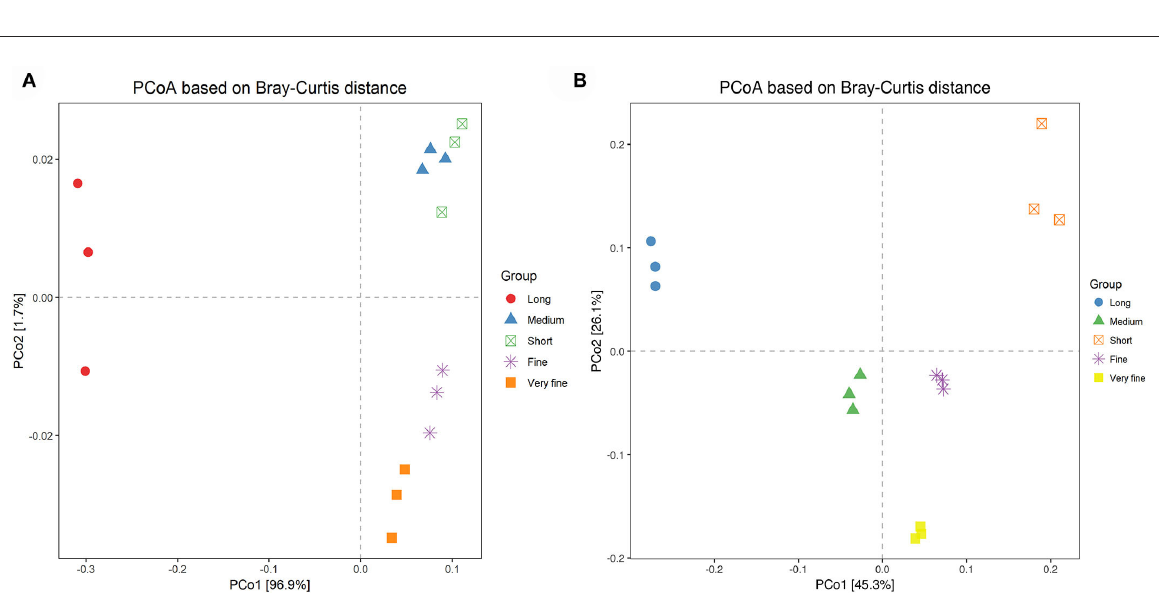
treatment. These results suggested strong differences in the fungal structure among the treatments. Moreover, the samples of 24.75% and 26.48% peNDF > 1.18 treatment were clustered in the same area, indicating that the fungal community structure of the two treatments was more similar to that of other